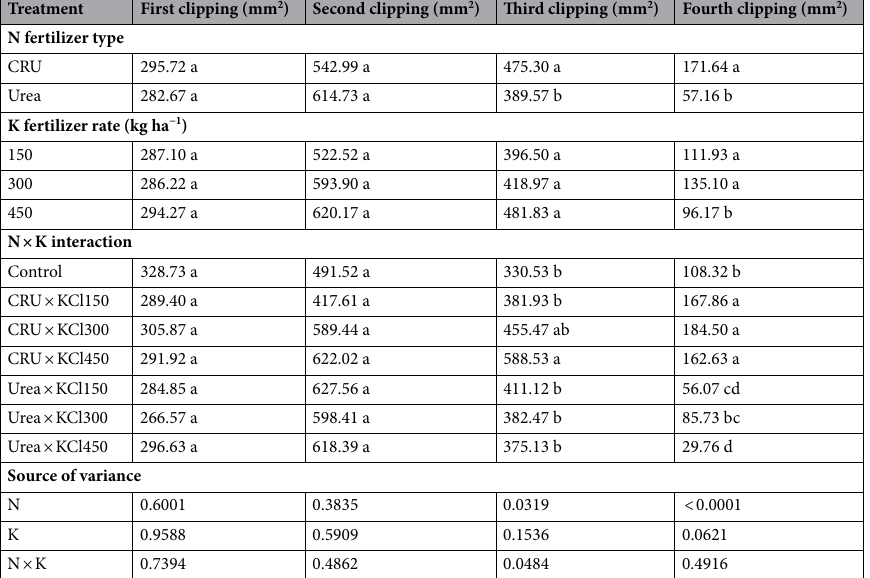
Table 2. The leaf area of Italian ryegrass. Means followed by different lowercase letters in the same column were significantly different based on analyses with ANOVAs followed by Duncan tests ( P < 0.05). Control no N and K fertilizer, CRU controlled-release urea, KCl potassium chloride.